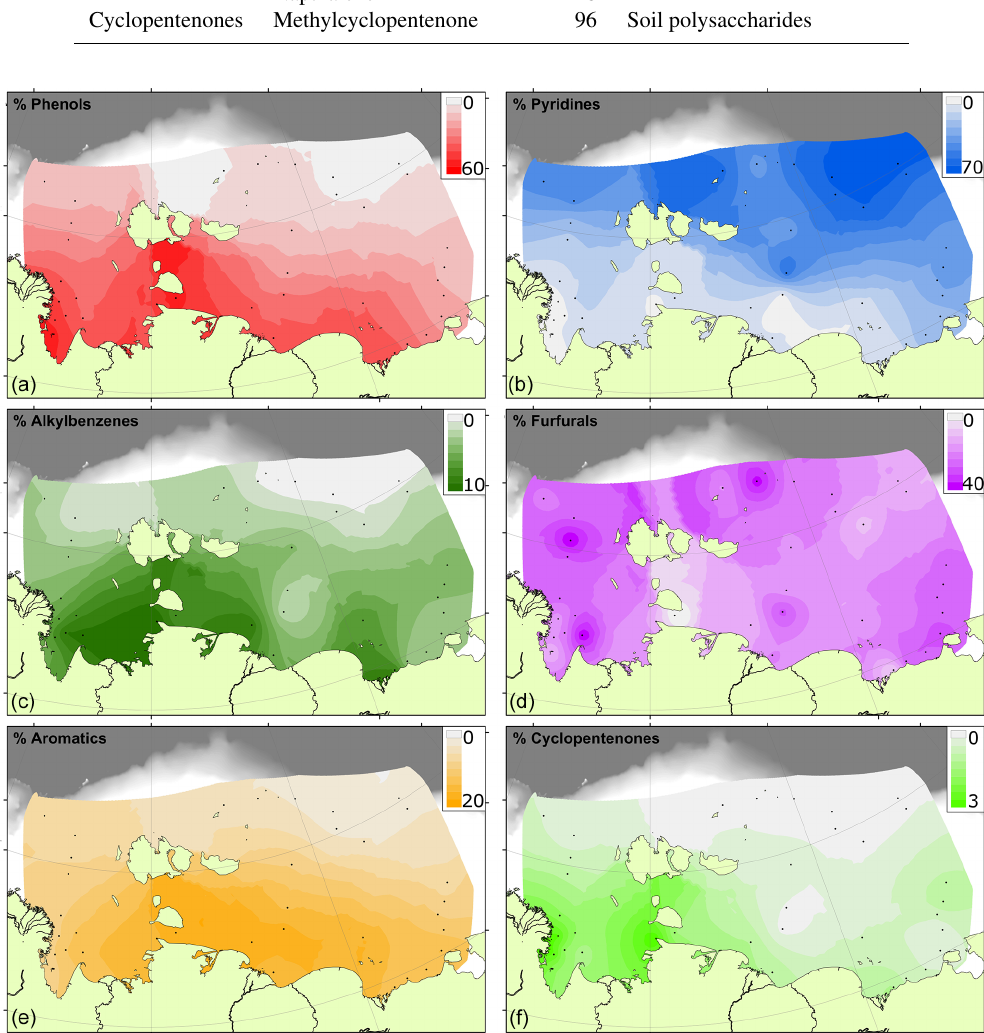
Figure 2. Distribution of (pyrolysis) compound classes across the ESAS. Distributions are reported as per cent of total, comparing the peak area of the major ion(s) in the compound class to the total peak area of major ions of all compound classes. See Table S2 for the breakdown of relative areas for each measured compound. Distributions are reported as a colour gradient from full colour (maximum observed) to white (zero). Sample locations are shown as black dots. Interpolation between sample sites was carried out using a “kriging” algorithm within the software package